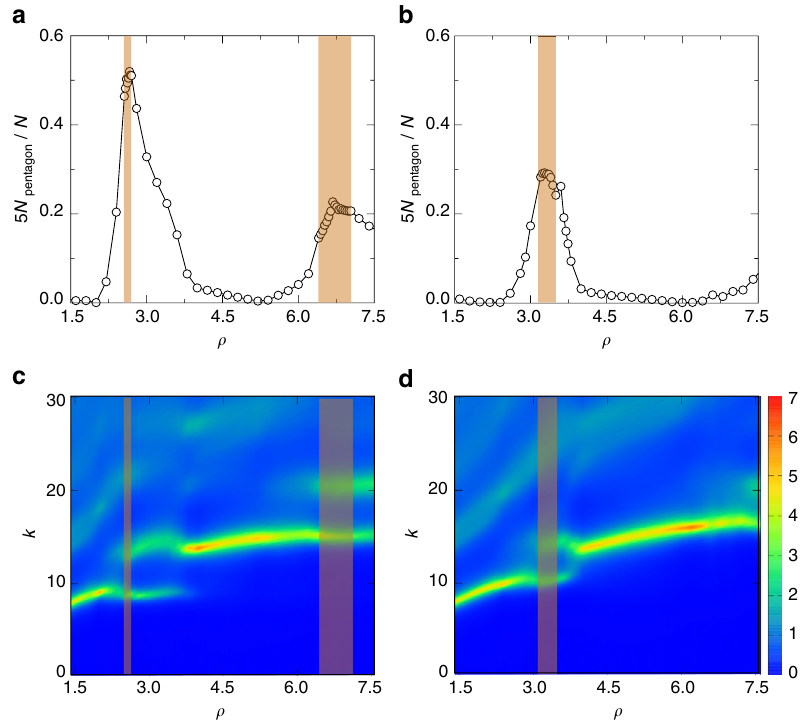
Fig. 4 Structural information in liquids. The left and right columns are for α = 2.0 and 2.5, respectively. a , b Density dependence of the fraction of particles forming pentagons, 5 N pentagon / N . c , d Contour plots of the static structure factors S ( k ) with the color bar quantifying the values of S ( k ). The liquids characterized here are slightly above the melting temperature at T = 1.1 T m . The shadowed density regimes in brown are where QCs